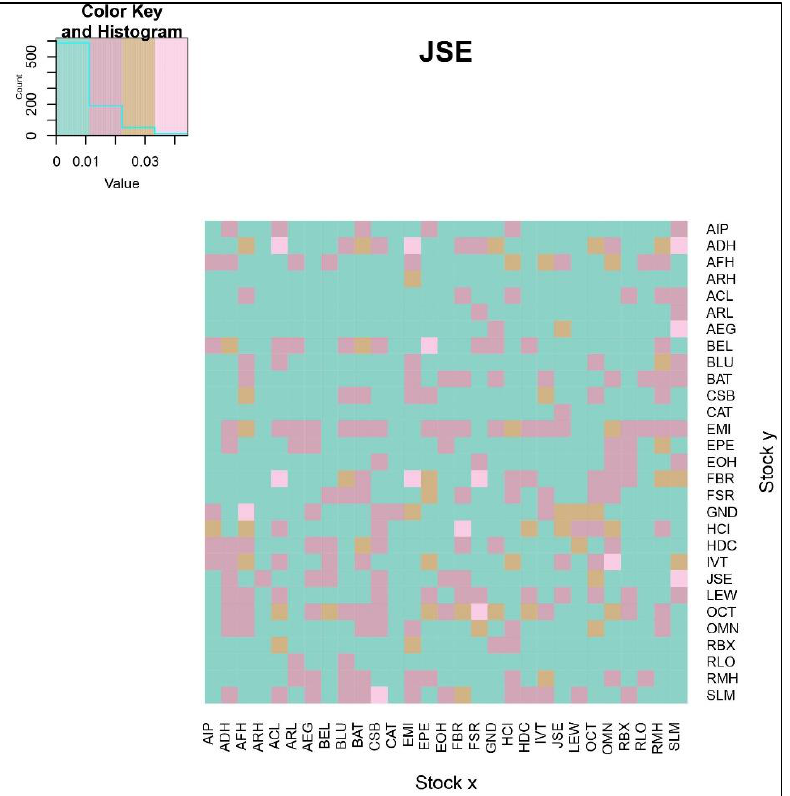
Figure 10. The information flow (effective transfer entropy) from stock y to stock x, for the top companies (by market capitalization) in the JSE market, after the COVID-19